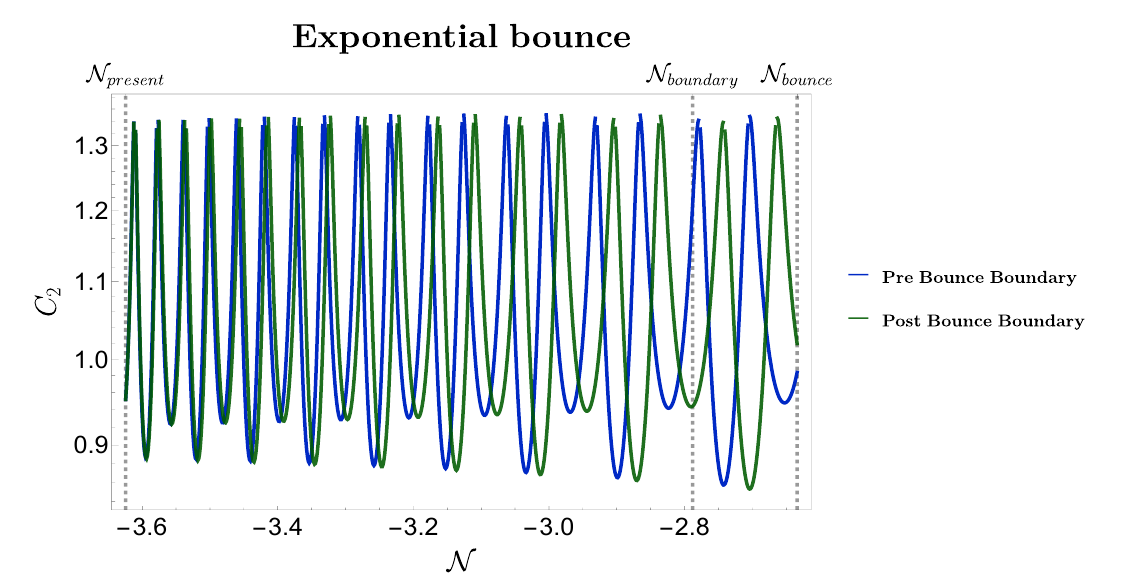
Figure 38: Variation of geodesically weighted complexity outside bouncing region with respect to number of e-foldings.